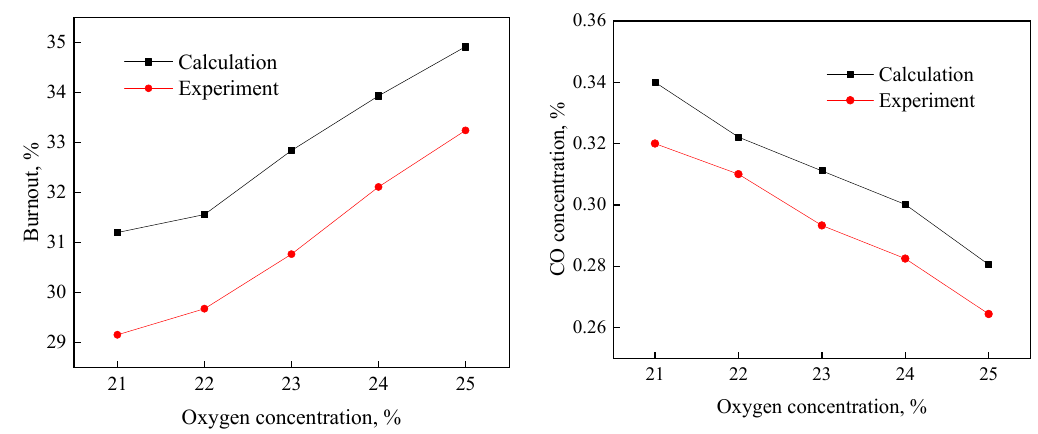
Figure 4. Effect of oxygen concentration on: coal burnout (left); CO concentration (right).